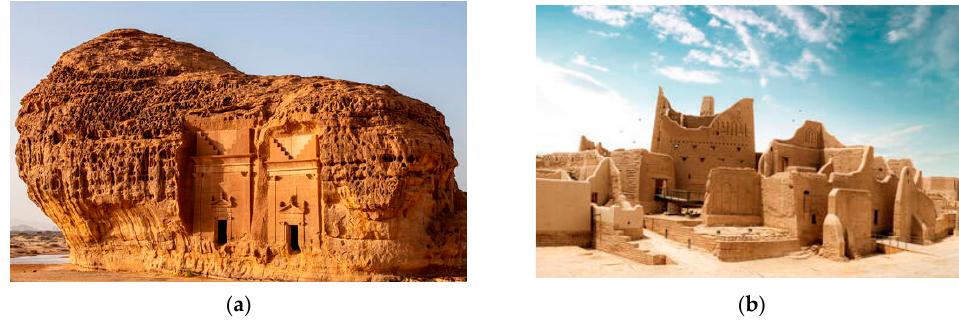
Figure 1. ( a ) Al-Hijr archaeological site (Madain Saleh) and ( b ) At-Turaif District in ad-Dir'iyah.